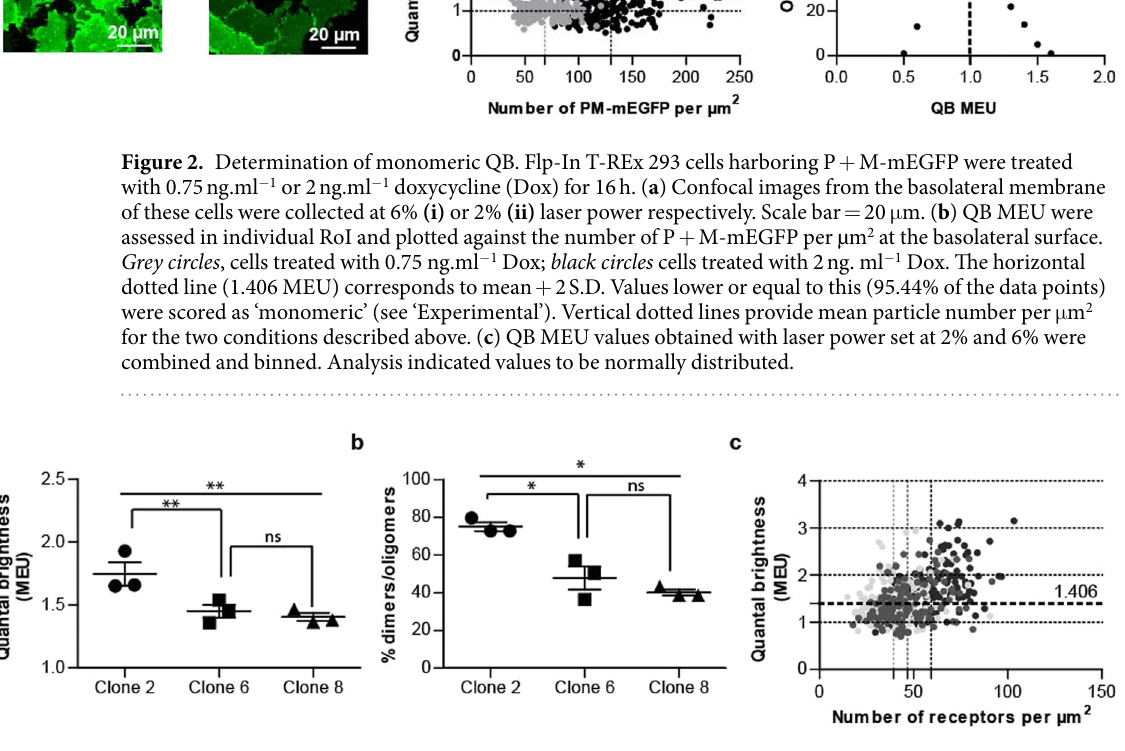
Figure 3. hD 3 R is present as a mixture of complexes: Complexity increases with receptor expression level. ( a ) Overall organizational state of hD 3 R-mEGFP, data is expressed as QB MEU value, with the average value from each experiment shown. Combined data from n = 3 × 44 (experiments × observations), error bars represent ± S.E.M. ** p < 0.01 when compared to the indicated clone, ns = not significant. ( b ) Assessment of percentage of RoIs containing predominantly dimers/oligomers (characterized by a value of QB MEU > 1.406). Combined data from n = 3 × 44 experiments, error bars represent ± S.E.M. * p < 0.05 when compared to the indicated clone, ns = not significant. ( c ) QB MEU were assessed in individual RoI and plotted against the number of hD 3 R-mEGFP per µ m 2 at the basolateral cell surface. Light grey circles , cells from clone 6; dark grey circles cells from clone 8, black circles , cells from clone 2. Horizontal dotted line represents 1.406 MEU, vertical dotted lines provide mean receptor number per μ m 2 for each